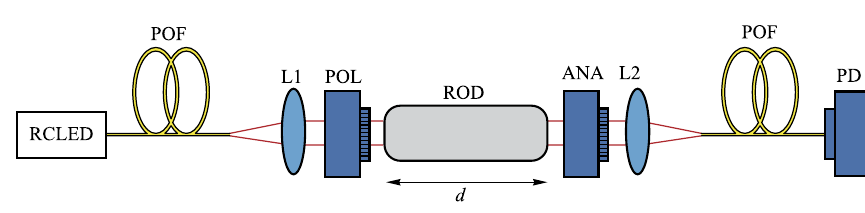
Fig. 17 Schematic representation of the optical head of the current sensor [88]. Copyright 2013, Zubia J. Reproduction with